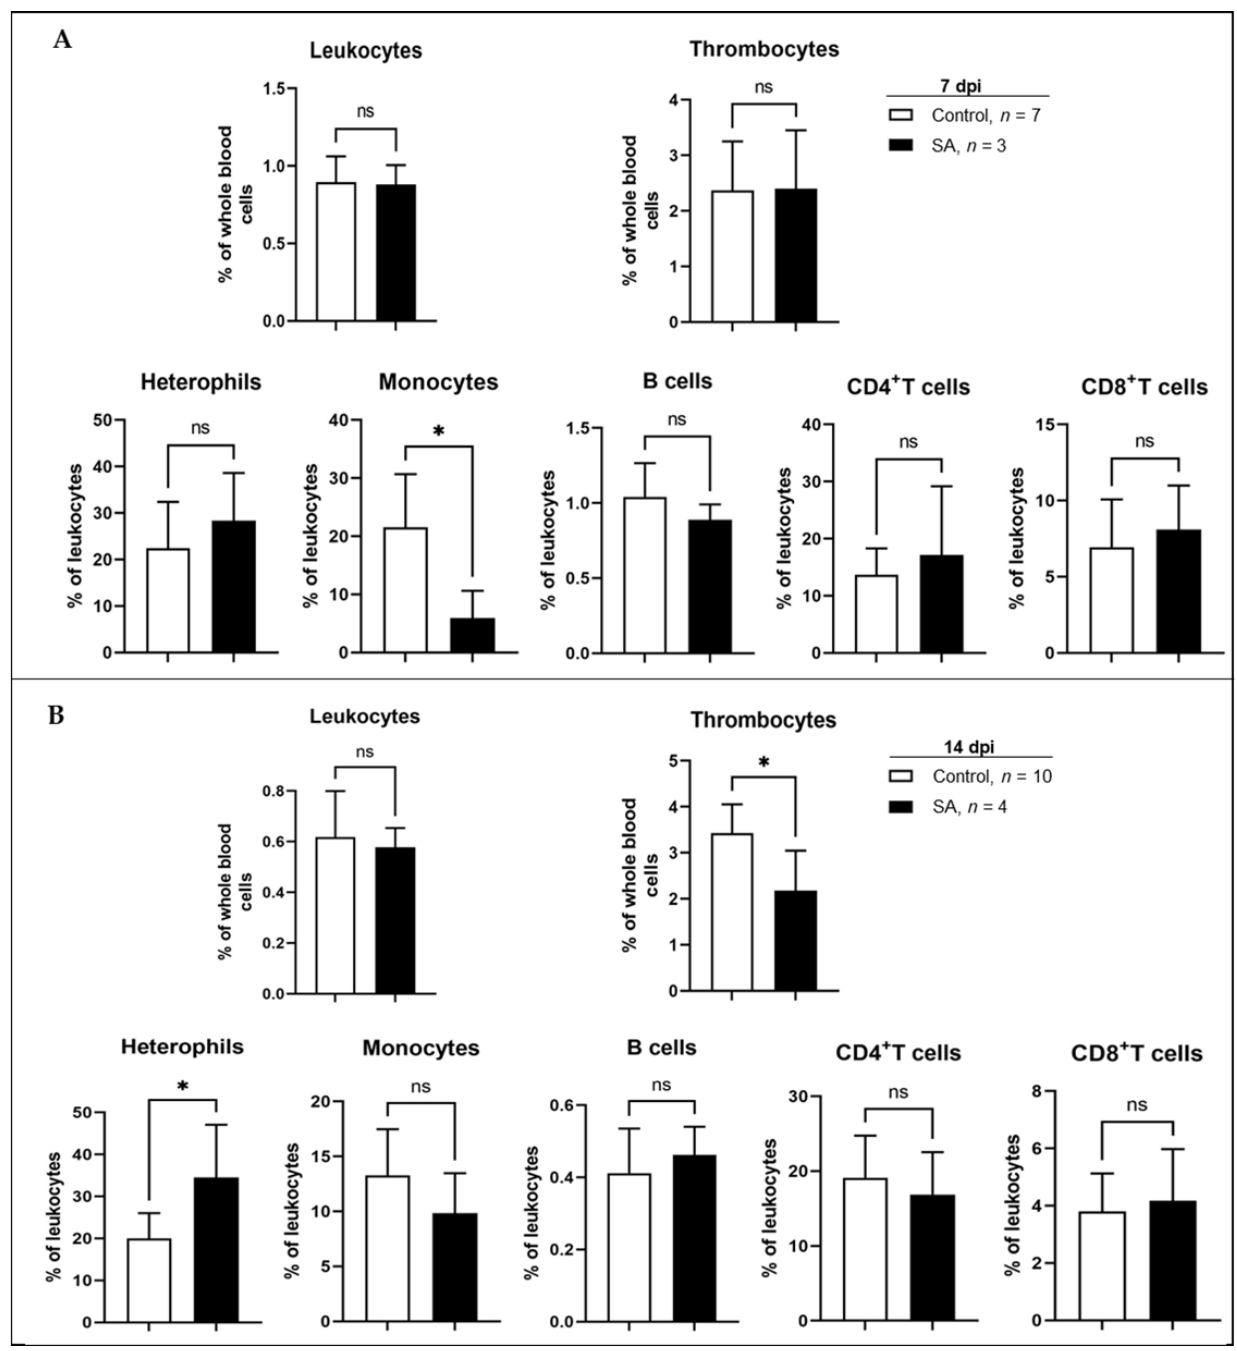
Figure 6. Effect of Salmonella inoculation on leukocyte populations. Whole blood, collected from 10 birds at 7 ( A ) and 14 ( B ) days post-infection, was subjected to flow cytometry to identify changes in leukocyte subpopulations. Samples displaying high amounts of clotting prior to processing were excluded. Significant differences were determined using the Student’s t -test and results were con- sidered significantly different at p < 0.05 (ns = Not Significant, * = p < 0.05).